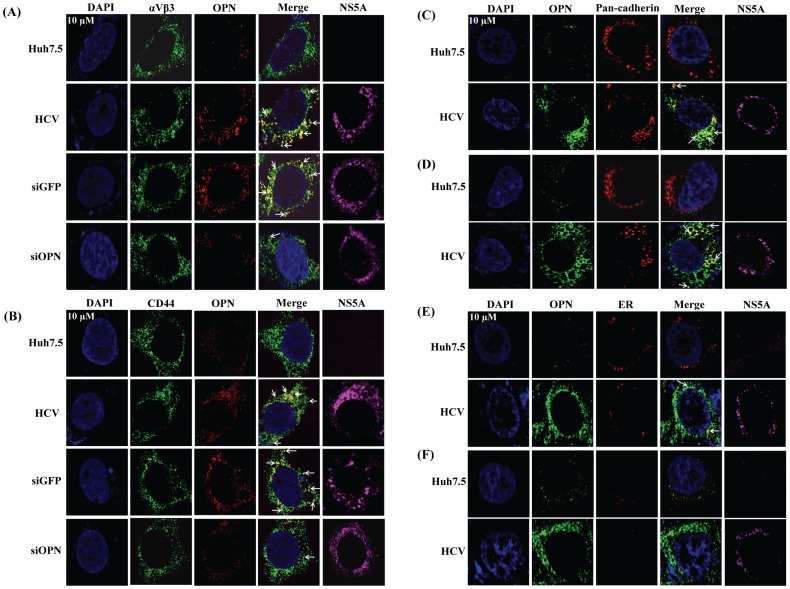

Colocalization of OPN with integrin αVβ3 and
                            CD44.
(A, B) Mock and HCV-infected cells (from figure 2A) were transfected with
                            siGFP and siOPN. At 72 h posttransfection, cells were permeabilized and
                            incubated with anti-OPN, anti-αVβ3, anti-CD44 and
                            anti-HCV NS5A antibodies for 1 h at RT, followed by incubation with
                            secondary antibodies; for OPN (anti-goat Alexa Fluor 546),
                            αVβ3 (anti-mouse Alexa Fluor 488), CD44 (anti-mouse
                            Alexa Fluor 488) and HCV NS5A (anti-rabbit Alexa Fluor 633). DAPI was
                            used as a nuclear stain. Arrows represent colocalization of OPN with
                            αVβ3 and CD44 respectively. HCV NS5A represents HCV
                            infection. Scale bar 10 µM. (C) Colocalization of OPN with
                            pan-cadherin (plasma membrane marker). Mock and HCV-infected cells (from
                                figure 2A) were
                            permeabilized and incubated with anti-OPN, anti-pan-cadherin and
                            anti-HCV NS5A antibodies for 1 h at RT, followed by incubation with
                            secondary antibodies; for OPN (anti-goat Alexa Fluor 546), pan-cadherin
                            (anti-rabbit Alexa Fluor 488) and HCV NS5A (anti-rabbit Alexa Fluor
                            633). (D) Similarly, non-permeabilized mock and HCV-infected cells were
                            incubated with anti-OPN and anti-pan-cadherin antibodies for 1 h at RT
                            and then cells were permeabilized and incubated with anti-HCV NS5A
                            antibody for 1 h at RT followed by 1 h incubation with above secondary
                            antibodies. DAPI was used as a nuclear stain. Arrows represent
                            colocalization of OPN with pan-cadherin. (E) Colocalization of OPN with
                            PDI (ER marker). As described in panel C and D, permeabilized cells were
                            incubated with anti-OPN, anti-PDI and anti-HCV NS5A antibodies for 1 h
                            at RT, followed by incubation with secondary antibodies; for OPN
                            (anti-goat Alexa Fluor 546), PDI (anti-rabbit Alexa Fluor 488) and HCV
                            NS5A (anti-rabbit Alexa Fluor 633). (F) Simultaneously,
                            non-permeabilized cells were incubated with anti-OPN and anti-PDI
                            antibodies for 1 h at RT and then cells were permeabilized and incubated
                            with anti-HCV NS5A antibody for 1 h at RT followed by 1 h incubation
                            with above secondary antibodies. DAPI was used as a nuclear stain.
                            Arrows represent colocalization of OPN with ER marker. HCV NS5A
                            represents HCV infection. Scale bar 10 µM.